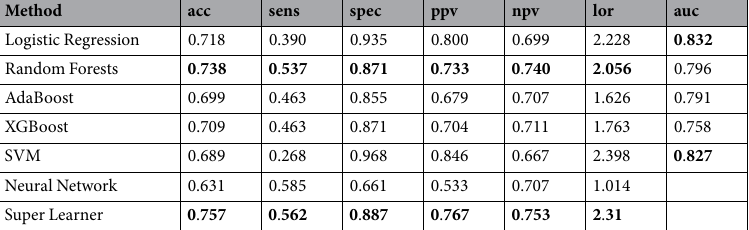
Table 22. Performance of model-based and model-free methods. Train on Michigan and test on Tel-Aviv data.